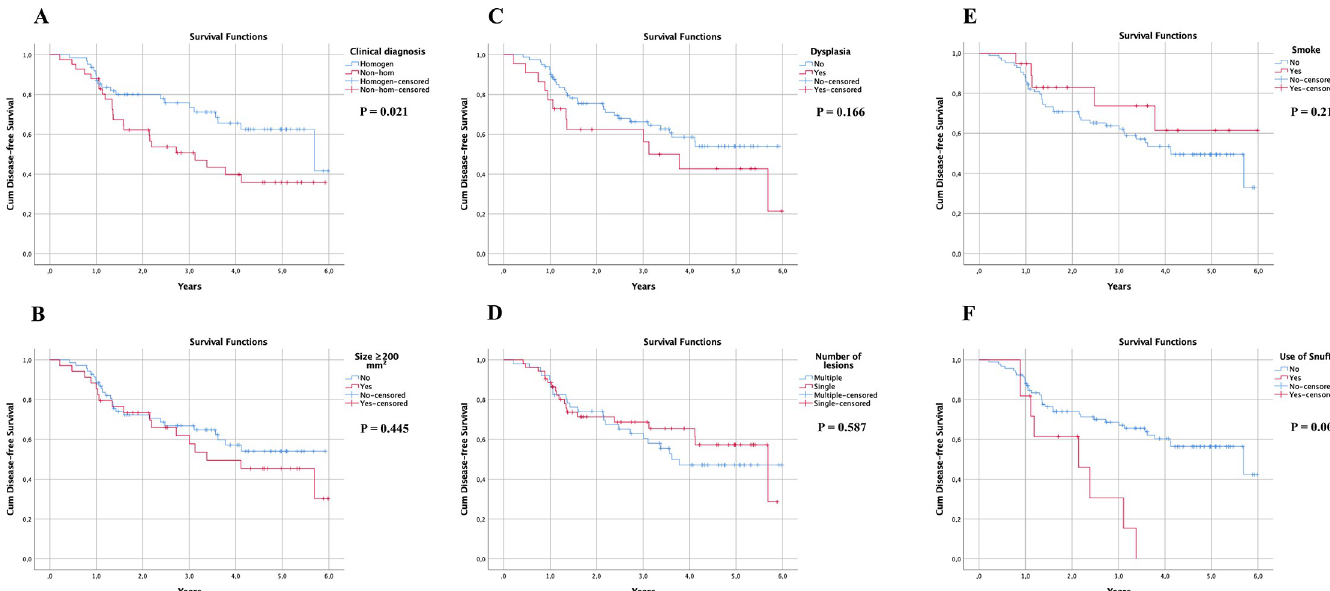
Fig 4. Kaplan-Meier curves for disease-free survival of patients with OL. Time shown is years from excision to recurrence. (A) Clinical diagnosis: P = 0.021; (B) Size: P = 0.445; (C) Dysplasia: P = 0.166; (D) Number of lesions: P = 0.587; (E) Smokers: P = 0.216; (F) Snuff users: P = 0.003.